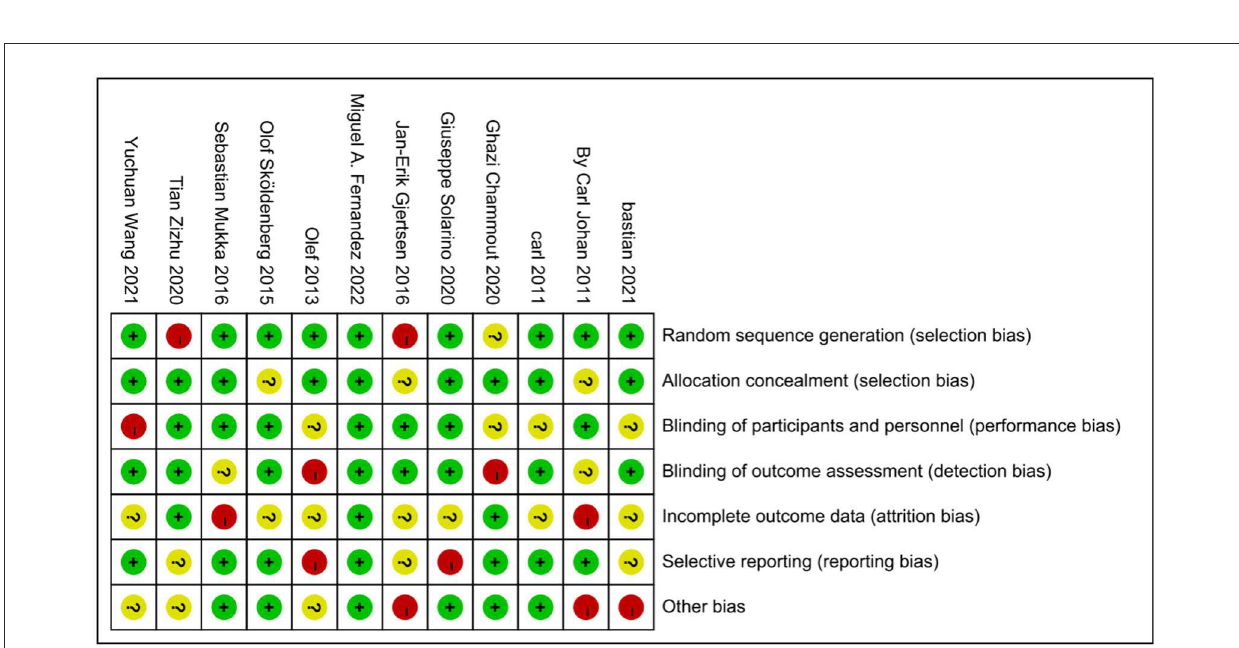
FIGURE3 Risk of bias summary of included studies.